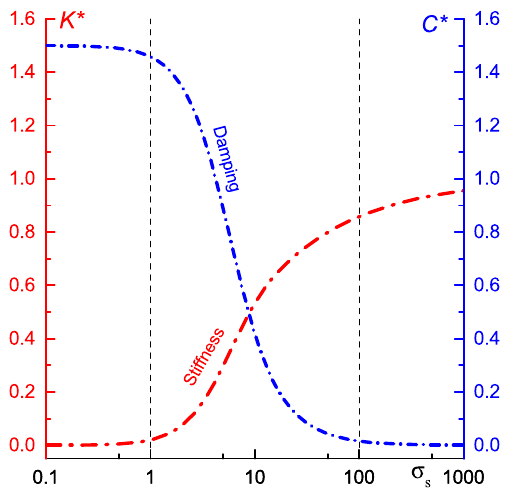
Figure 6. Dynamic coefficients of the 1D parallel disc.